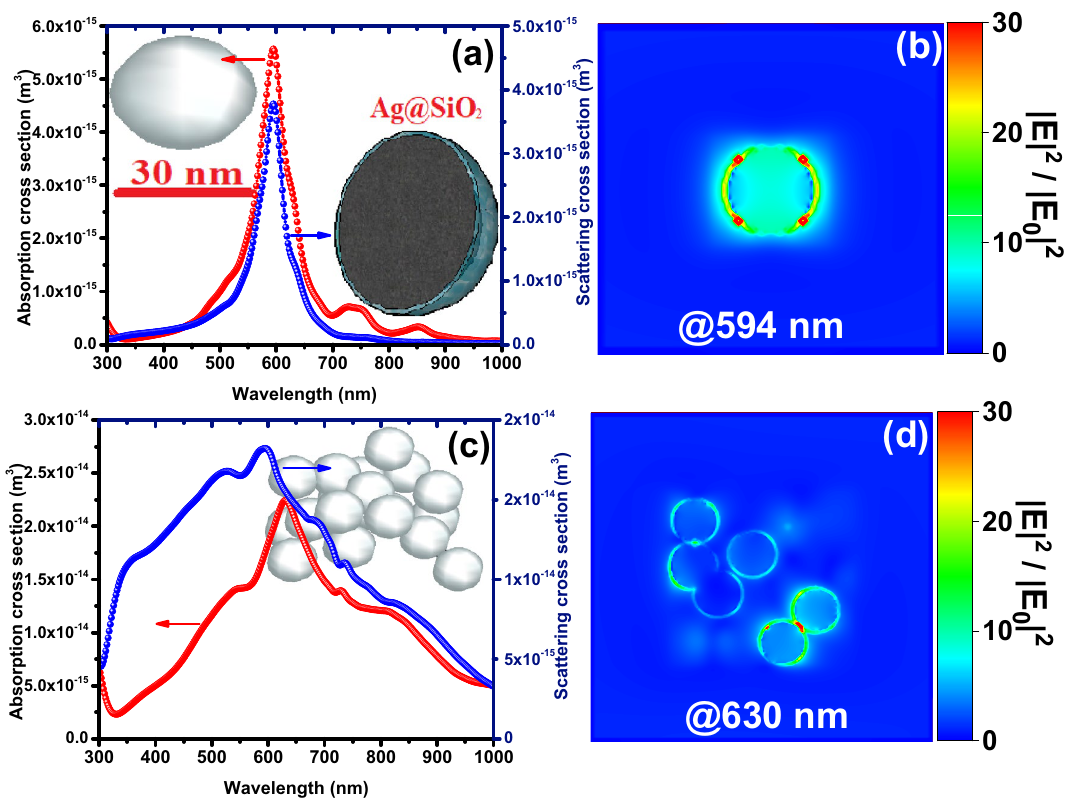
Figure 5. Absorption and scattering cross-sections ( a , c ) and near-field intensity enhancement ( b , d ) of ( a , b ) single and ( c , d ) a mass of 20 core–shell Ag@SiO 2 nanospheres (1 nm SiO 2 utter shell and total size of 32